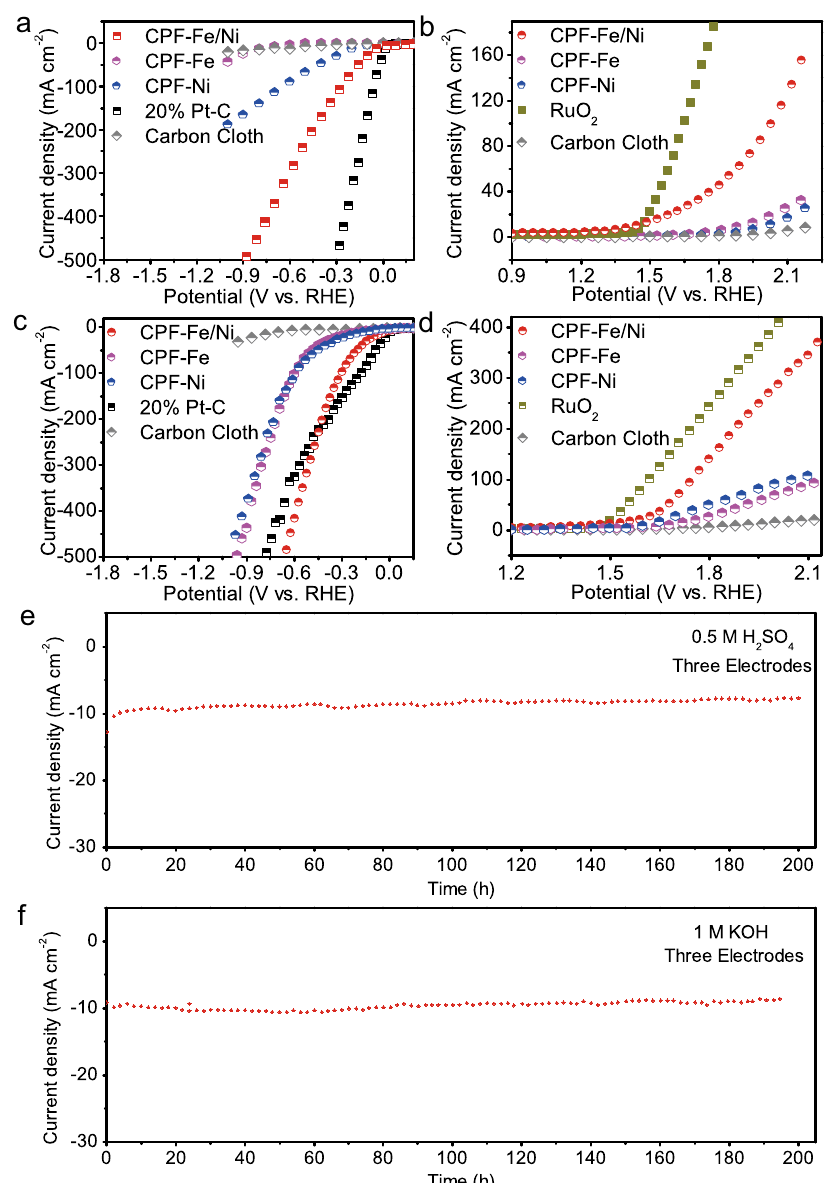
Fig. 3 | HER and OER performance overall water-splitting performance of the CPF-Fe/Niin0.5MH 2 SO 4 and1MKOH.a HERand b OERpolarizationcurveswith a speed of 10mVs − 1 in 0.5M H 2 SO 4 ; c HER and d OER polarization curves with a speed of 10mVs − 1 in 1M KOH aqueous solution; The chronopotentiometry curves